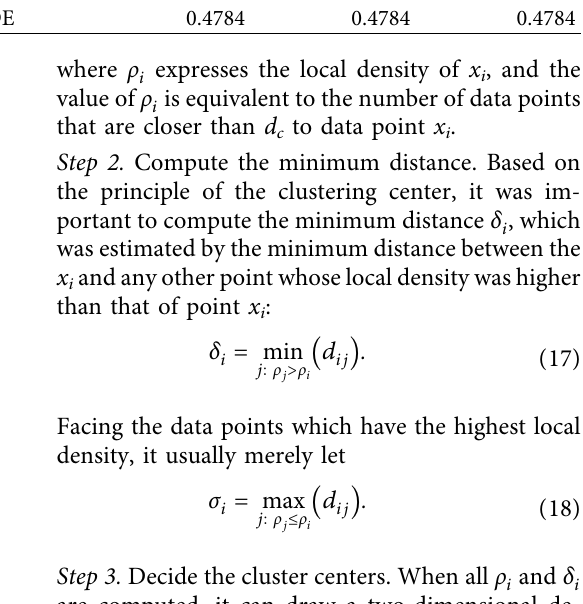
Table 1: The FDE and DE values of the three constructed simu- lation signals.